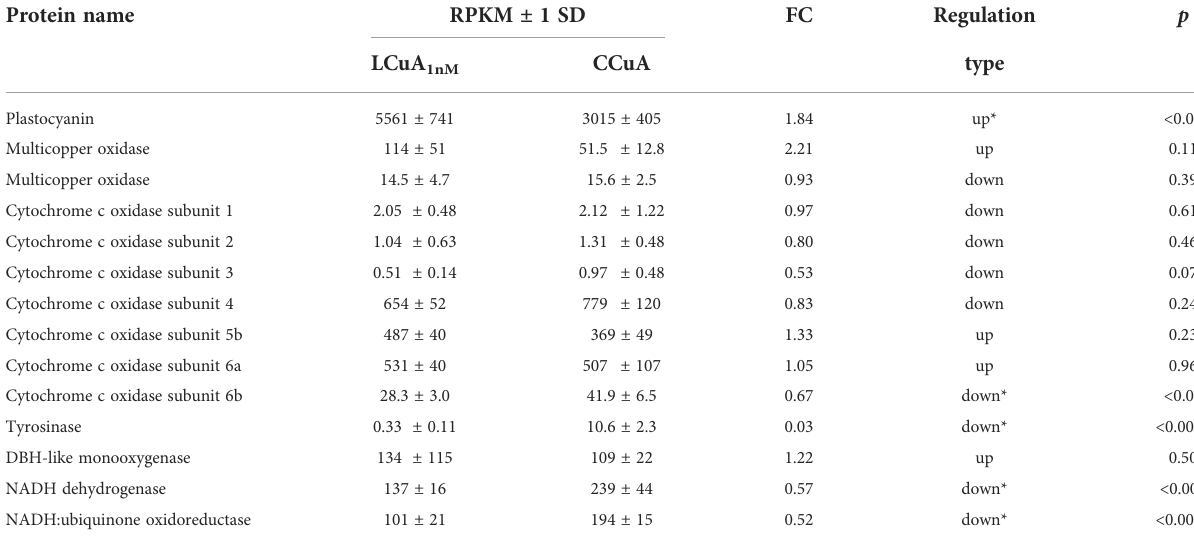
TABLE 4 Gene transcript abundance of Cu-containing proteins in low Cu-adapted (LCuA 1nM ) and control (CCuA) populations. Protein